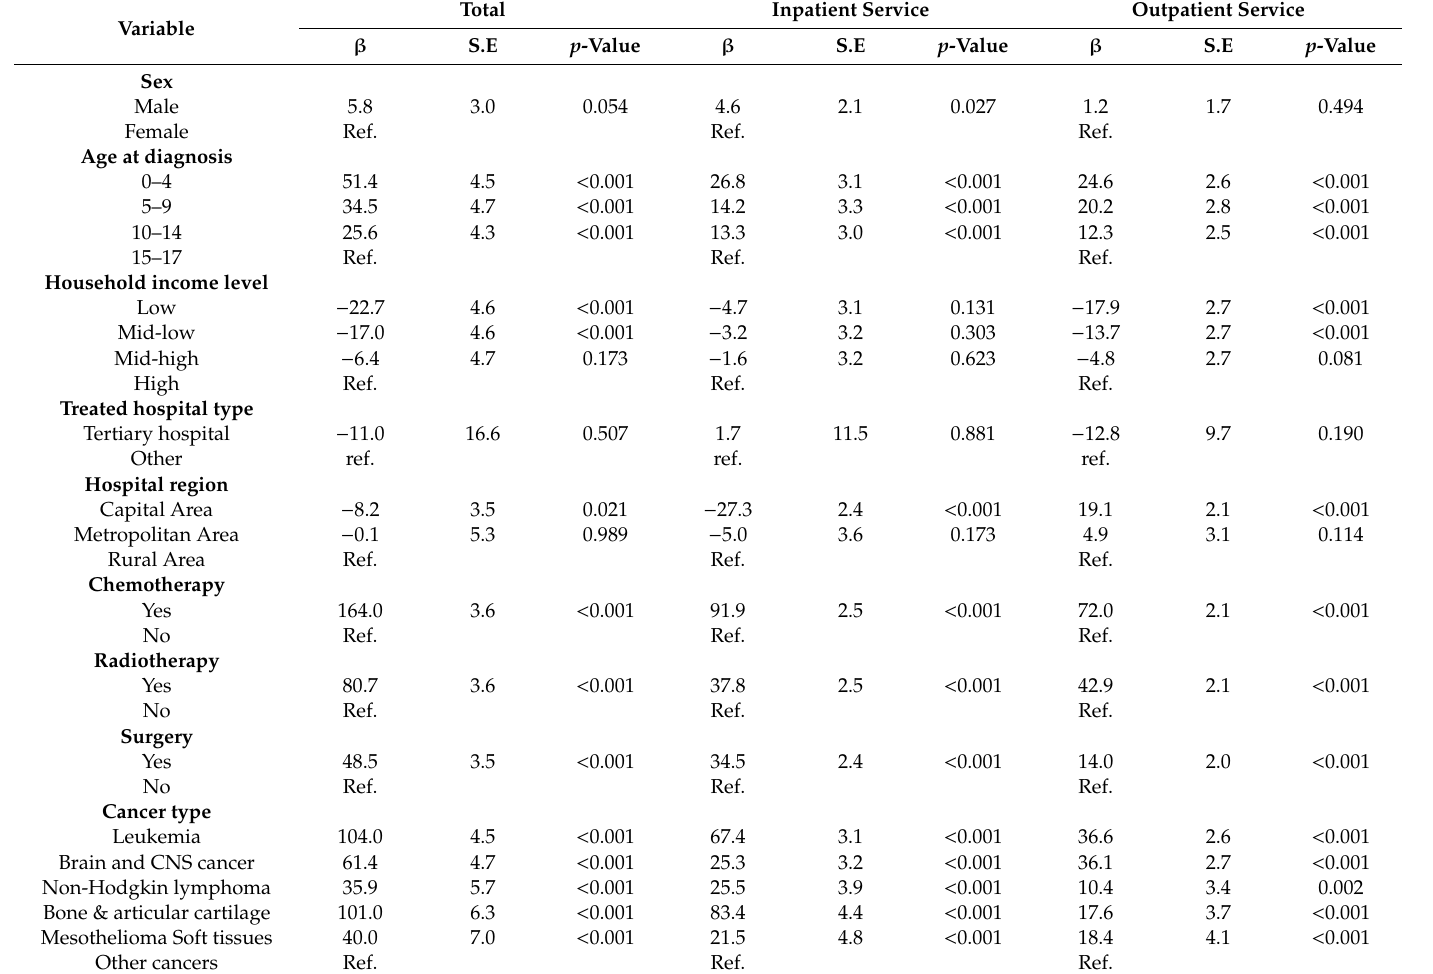
Table 4. Result of regression analysis on the duration of medical service